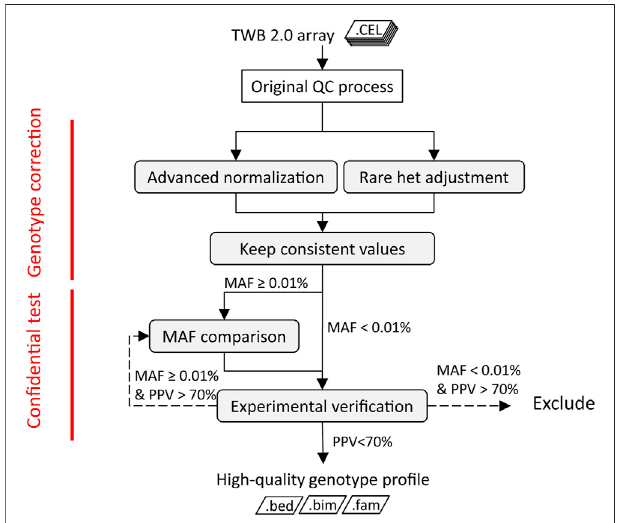
FIGURE1| Quality-controlprocedureofTWB2.0arraysofrarevariants. The shaded boxes are steps of the rare variant quality-control procedure. The dotted line represents the management of variants with low